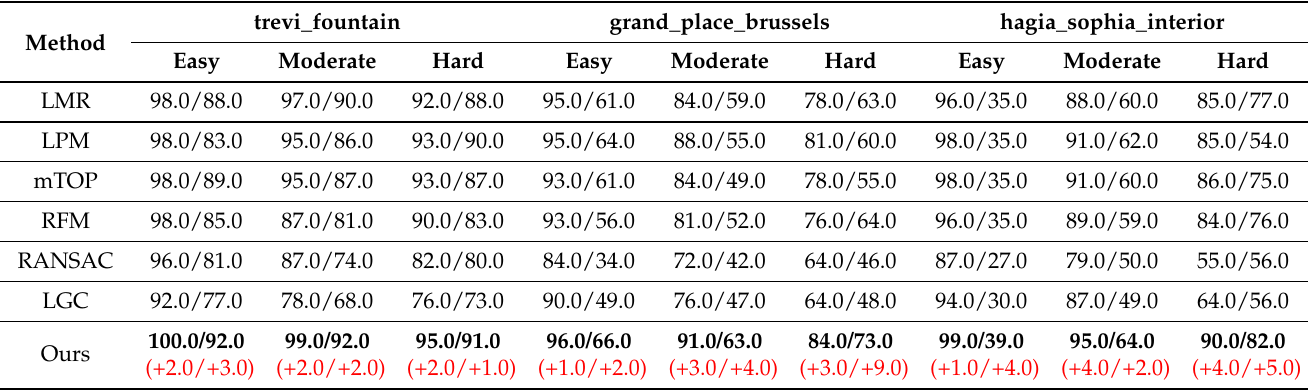
Table 5. Relativepose estimation accuracy (%) on three scene of ChallengeData. Each cell represents the accuracy of rotation estimation (left) and the accuracy of translation estimation (right). The esti- mation of an image pair is successful when the angle error is under a certain threshold (10 ◦ ). The best results are in bold. The red numbers in the brackets indicate the improvement between the best and the second best results.